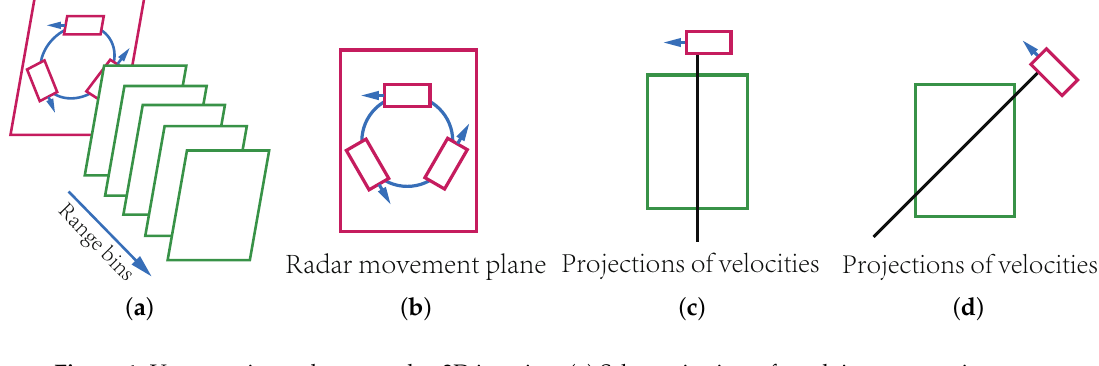
Figure 1. Uses rotation radar to resolve 3D imaging. ( a ) Schematic view of resolving range using range bins; ( b ) the swinging within the rotation plane of the radar generates velocities in different directions; ( c , d ) each range bin is then projected into different velocity directions while data are